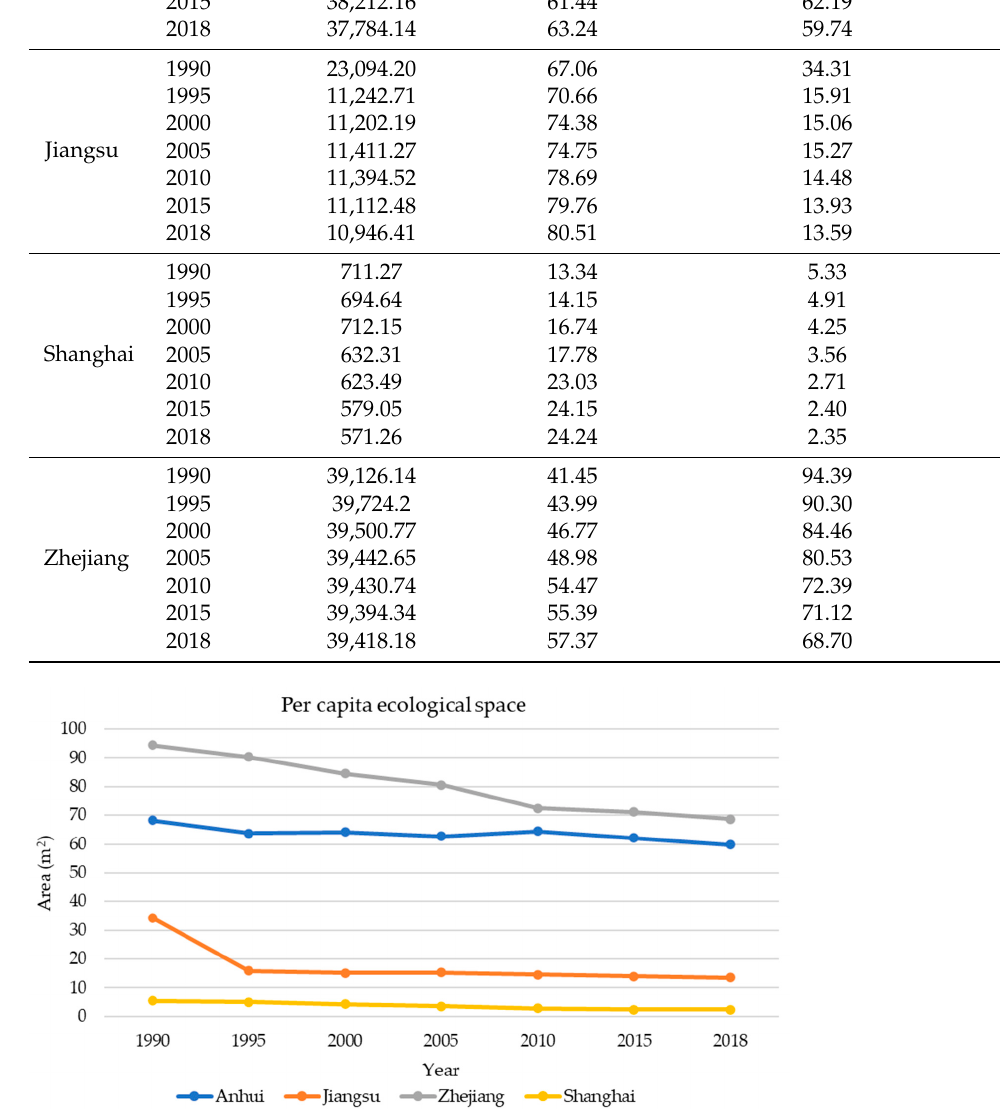
Figure 5. Change curves of per capita ecological space of each Province in the Yangtze River Delta Urban agglomeration.